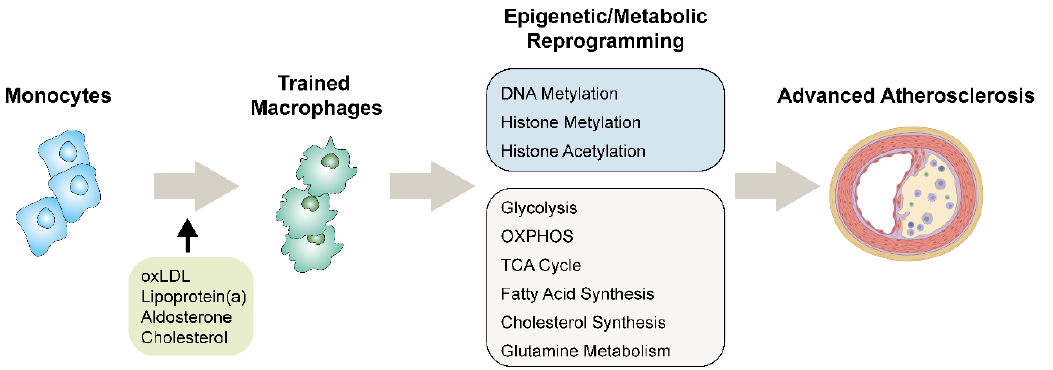
Figure 1. The functions and mechanisms of activated innate immune memory in monocytes/macro ‐ phages during the development of atherosclerosis. The activated innate immune memory of mac ‐ rophages induces epigenetic and metabolic reprogramming, which increases the production of pro ‐ inflammatory cytokines, leading to a proatherogenic